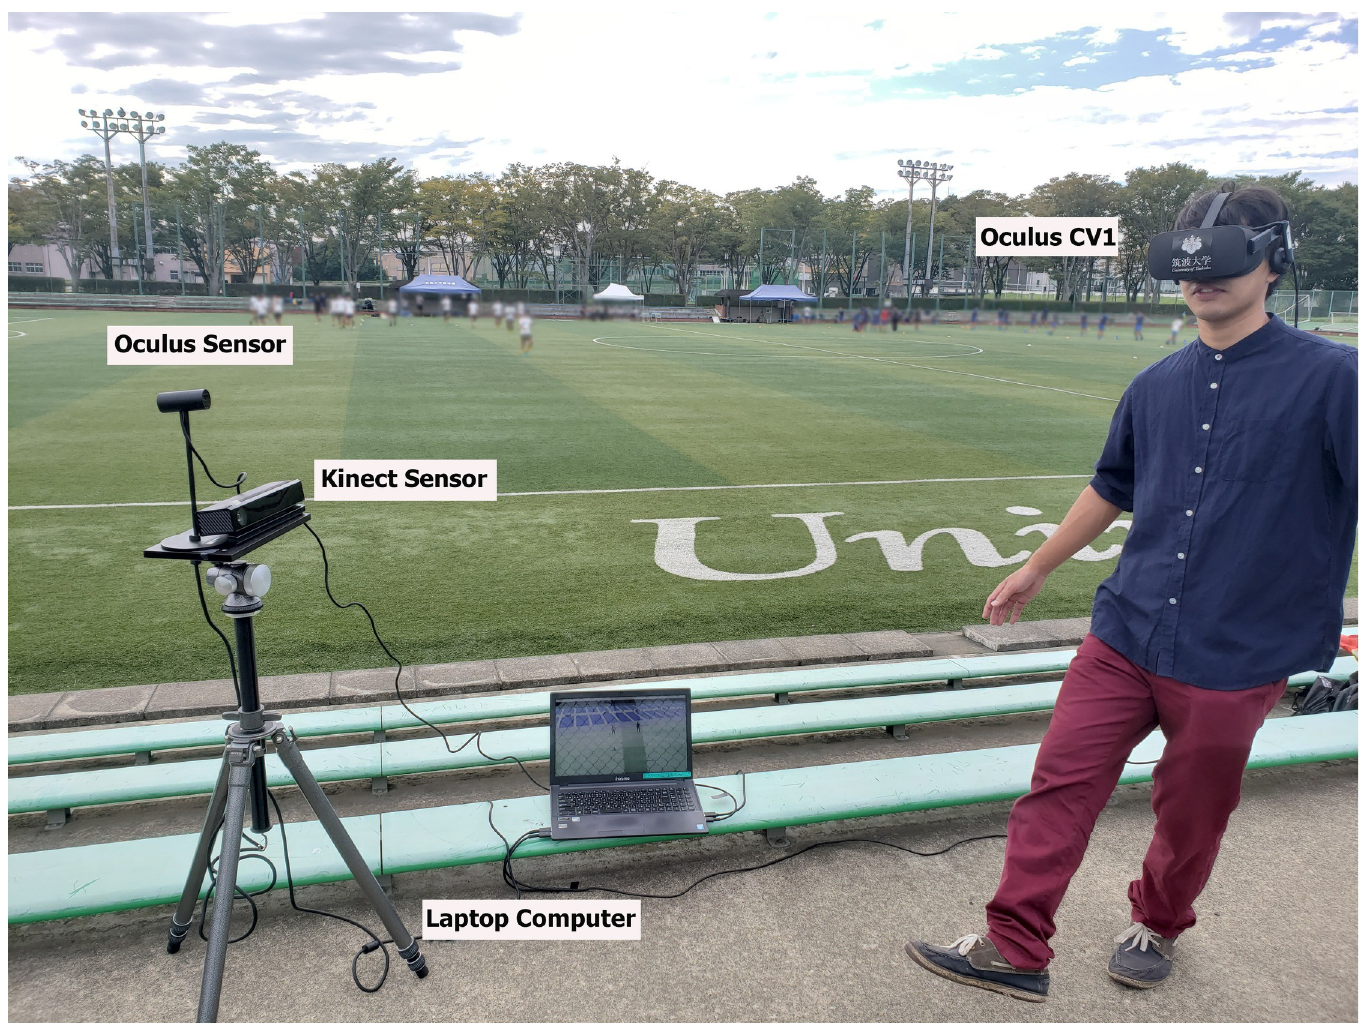
Fig 12. Volunteer experiments the VR simulation: Making a passing gesture inside VE. The image highlights the main components of the setup.